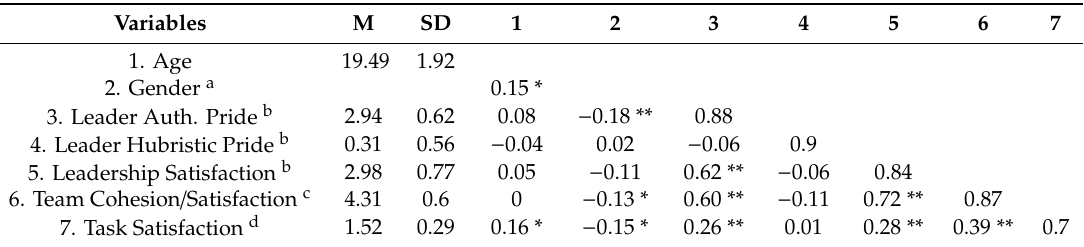
Table 1. Descriptives and Correlation table between research variables ( N = 179).